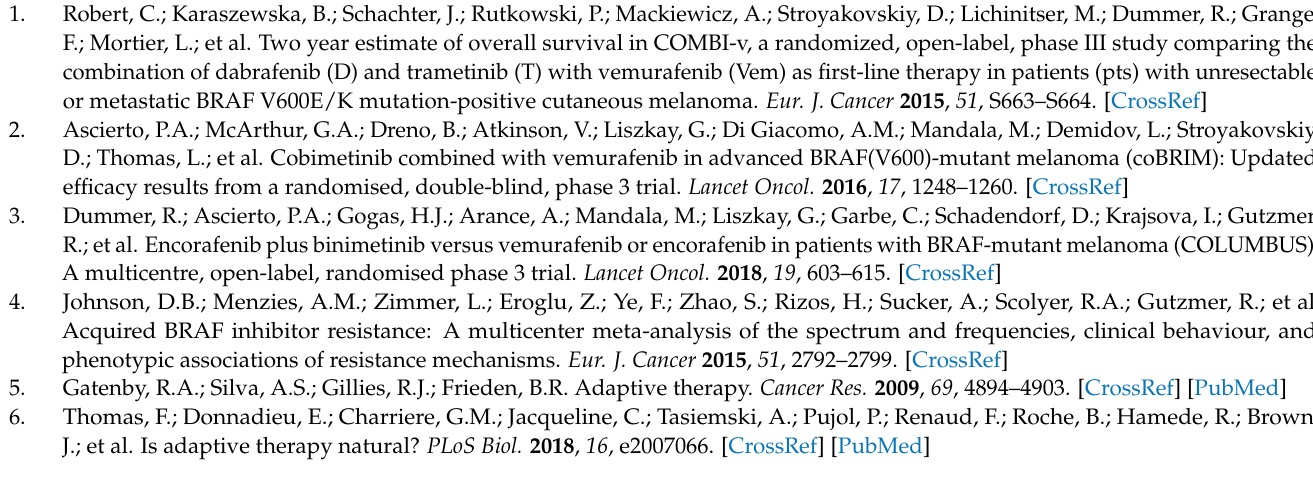
evaluation data, Figure S2: LV model calibration, Figure S3: SW model calibration, Figure S4. LV model parameter variability assessment, Figure S5. L 2 norm of LV model calibration errors, Figure S6. SW model parameter variability assessment, Figure S7. L 2 norm of SW model calibration errors, Figure S8. LV model predictions with perturbed parameters, Figure S9. SW model predictions with perturbed parameters, Figure S10. Model fitting to the patient 1 data, Figure S11. Model projection of drug-resistant population ( R